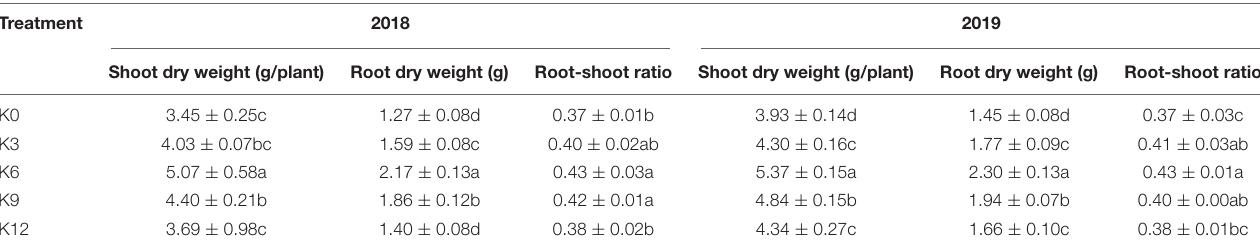
TABLE 2 | Plant biomass and root/shoot ratio of M9T337 seedlings treated with K0 (0 mM K + ), K3 (3 mM K + ), K6 (6 mM K + ), K9 (9 mM K + ), or K12 (12 mM K + ) in 2018 and 2019.